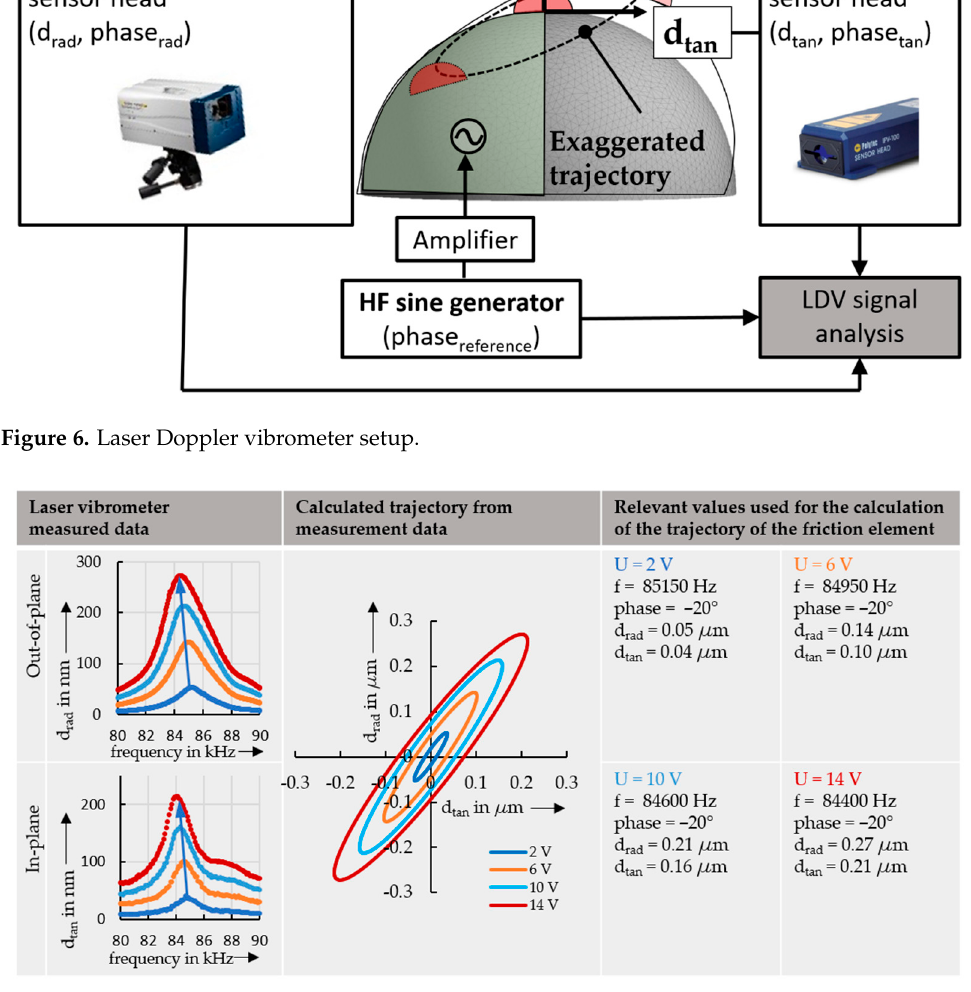
Figure 6. Laser Doppler vibrometer setup.